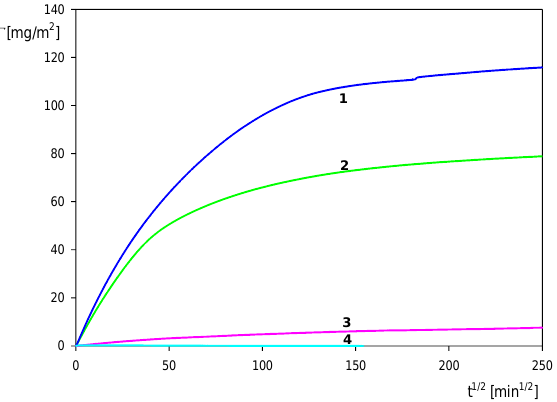
Figure 12. Kinetics of the polymer particle with HSA corona deposition on the gold sensor derived from QCM measurements for various pHs: the corona coverage 0.80 mg m − 2 , 10 mM NaCl, cb = 50 mg L − 1 , flow rate 2.5 × 10 − 3 mL s − 1 . The solid lines show the experimental data derived from the Sauerbrey model for the third overtone: 1. pH 4.0, 2. pH = 4.5, 3. pH = 5.5, 4. pH = 7.4.